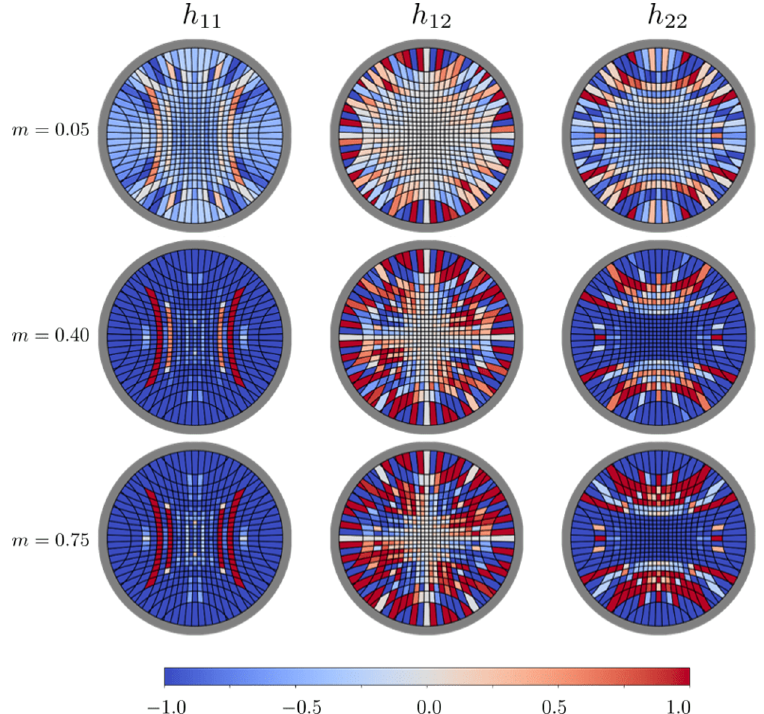
Figure 9. Components of the reconstructed metric tensor perturbation corresponding to the ground state of a globally mass deformed Hamiltonian (with m values as shown), with deformations located at every other site. The relative errors are approximately E bdy ≈ 0 . 25 for this set of plots (see figure 13b).